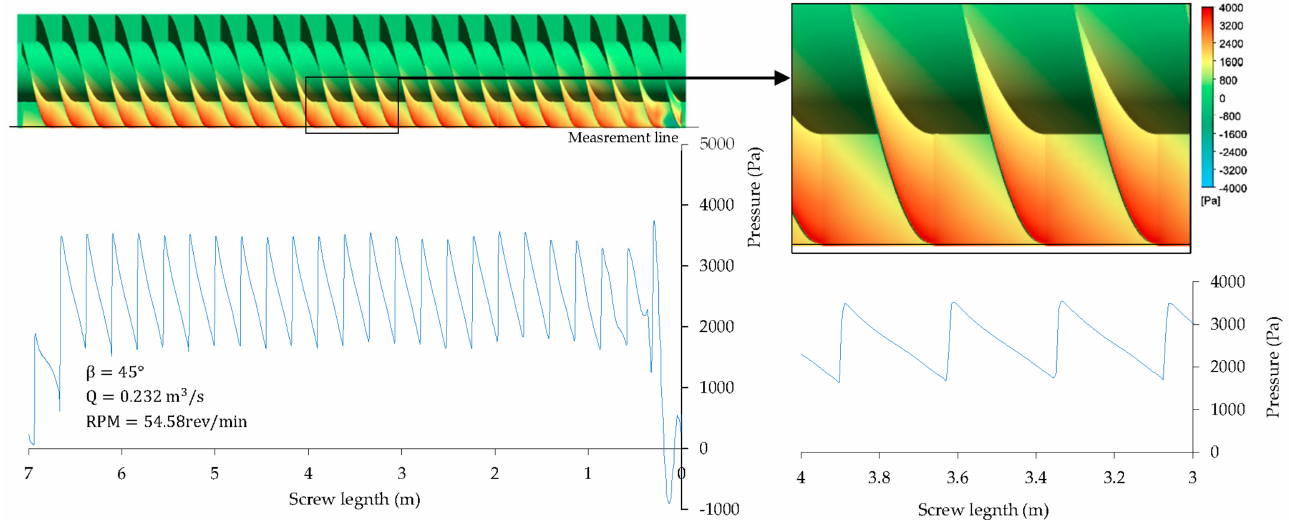
Figure 13. Pressure variation along the screw